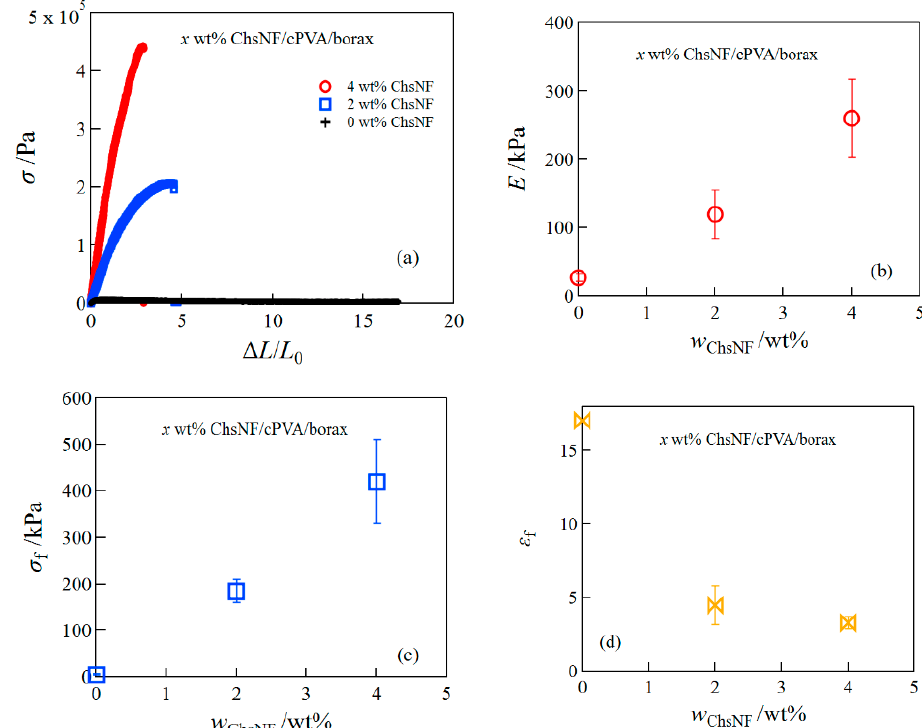
Figure 1. Tensile stress–strain curves ( a ), the Young (cid:48) s modulus ( b ), fracture stress ( c ), and fracture strain ( d ) for ChsNF/cPVA/borax